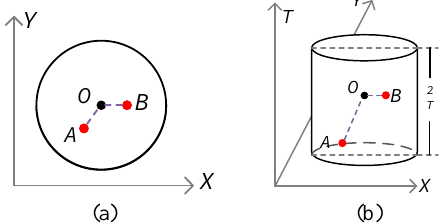
Figure 2. The comparison of interaction in different dimension. (a) The neighbourhood in traditional data filed, (b) The neighbourhood in spatiotemporal data